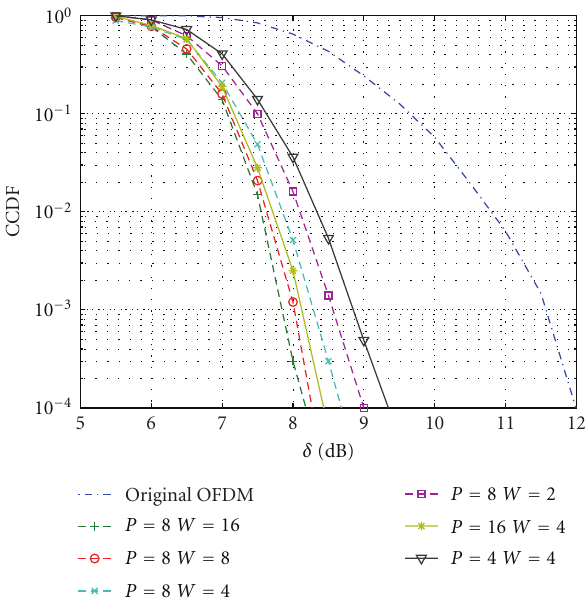
Figure 5: Complementary CDF of the OFDM signal for various P and W with N = 256 and pseudorandom subblocks.